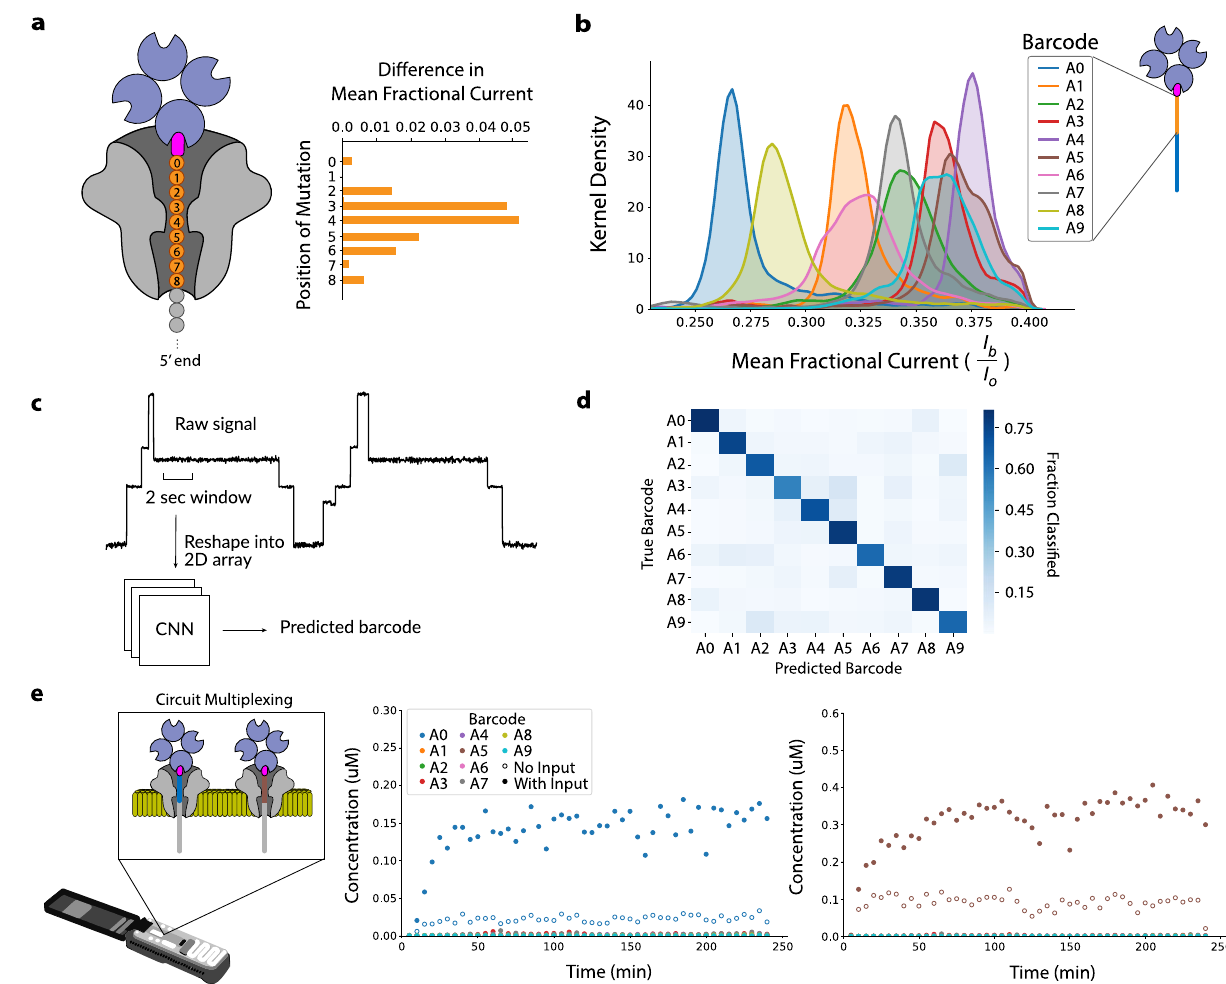
Fig. 3 | Initial barcode design, classi fi cation, and multiplexing. a Mapping the output strand nanopore-sensitive region. The plot shows the absolute change in mean fractional ionic current manifested by a single-nucleotide mutation at dif- ferent positions along the strand. b Density plot showing the distribution of mean fractional current for each barcode in Set A. Each distribution is composed of ~14500 data points. c To perform classi fi cation, a two-second (20,000 data point) window of the output strand capture event signal is extracted, reshaped into a 2D array,andthenusedasinputtoa2DResNet-18CNN.TheCNN ’ soutputisabarcode